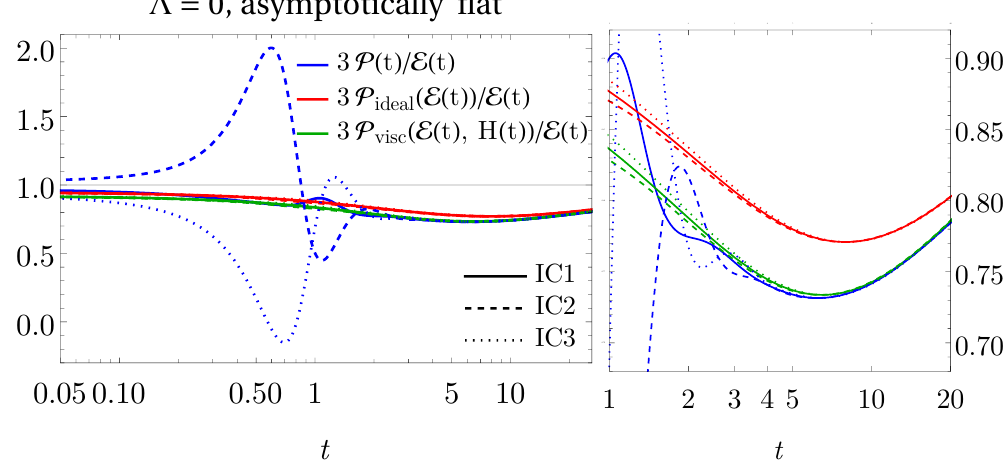
Figure 3 . Comparison between the holographic result for the pressure/energy ratio (blue) and the ideal (red) and viscous (green) hydrodynamic approximations, for G = 1 / 750 , Λ = 0 and three different initial